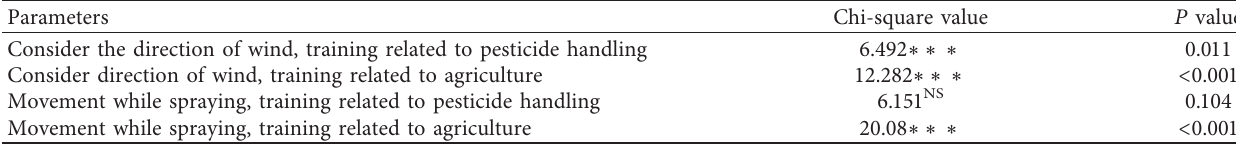
Table 4: Chi-square association between handling of pesticide and